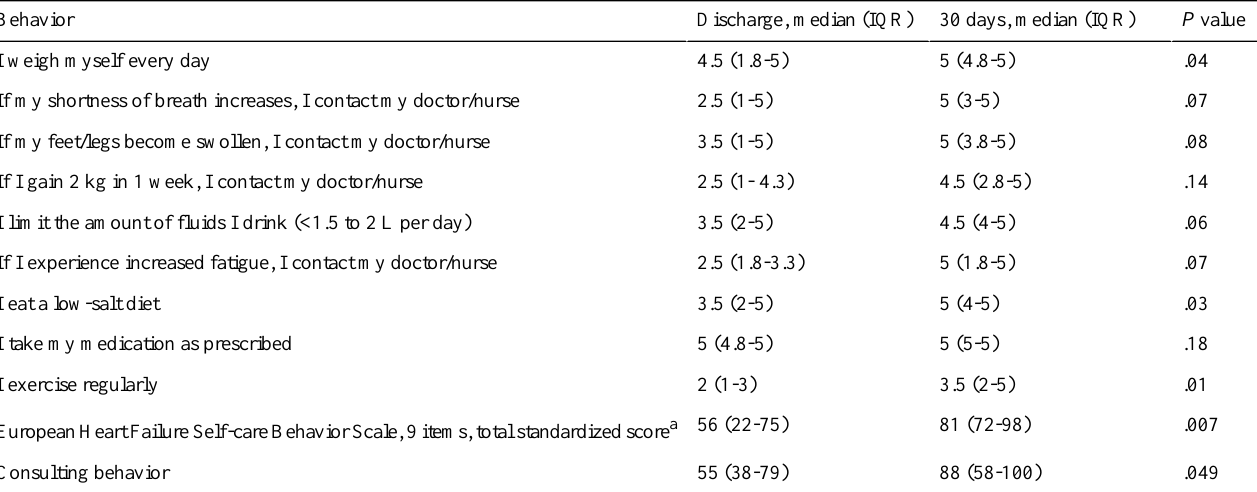
Table 4. Comparison of heart failure participants’self-care behavior at hospital discharge and 30 days later at the outpatient clinic as assessed with the European Heart Failure Self-care Behavior Scale (European Heart Failure Self-care Behavior Scale-9 comprises 9 items scored on a Likert scale of 1-5, with a higher score indicating better adherence to the given behavior; N=10).